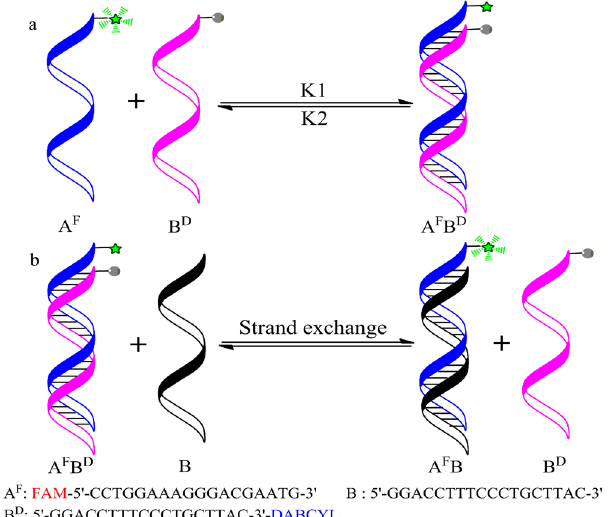
Figure 1. ( a ) Experimental schematic of DNA hybridization. ( b ) The principle of DNA strand exchange detection by using fluorescence resonance energy transfer (FRET) and the oligonucleotide sequences used. Two DNA strands A F and B D were respectively labeled with fluorescein at the 5 ′ -end and DABCYL at the 3 ′ -end. A F was complementary to B or B D . The fluorescence emission increased when B D strand was exchanged by B, due to the dissociation of FAM-DABCYL FRET